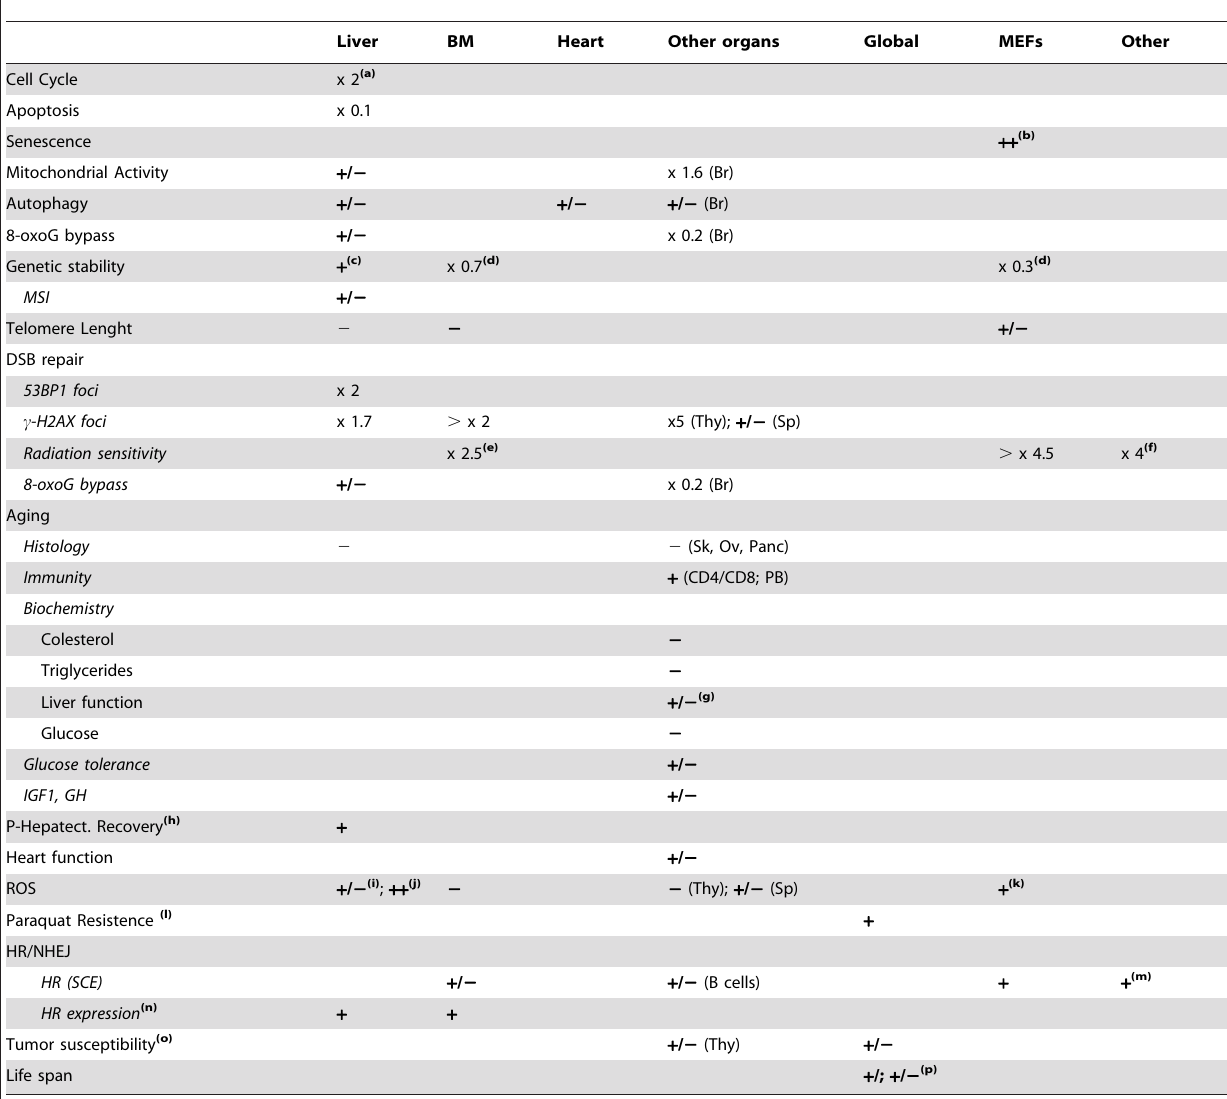
Table 1. Summary of different physiological parameters analyzed in old Pol m 2 / 2 mice.